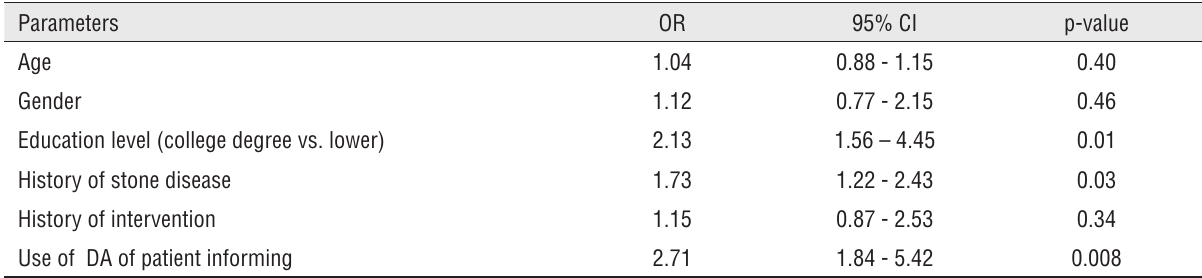
Table 3 - Univariate logistic regression models for having adequate level of knowledge. The outcome variable is whether or not correctly answered at least 8 out of 10 questions (yes vs.